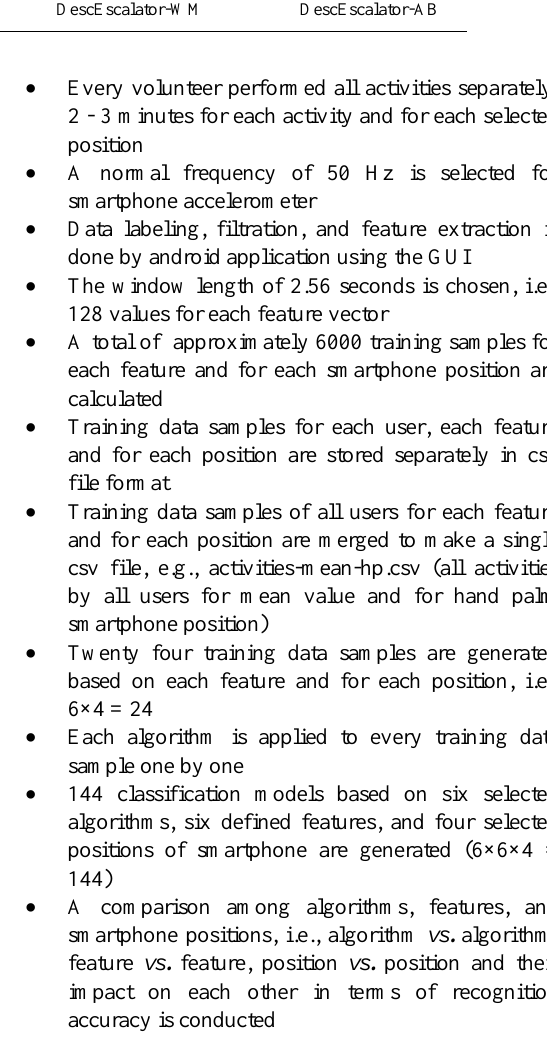
Each algorithm is applied to every training data sample one by one  144 classification models based on six selected algorithms, six defined features, and four selected positions of smartphone are generated (6×6×4 = 144)  A comparison among algorithms, features, and smartphone positions, i.e., algorithm vs. algorithm, feature vs. feature, position vs. position and their accuracy is conducted